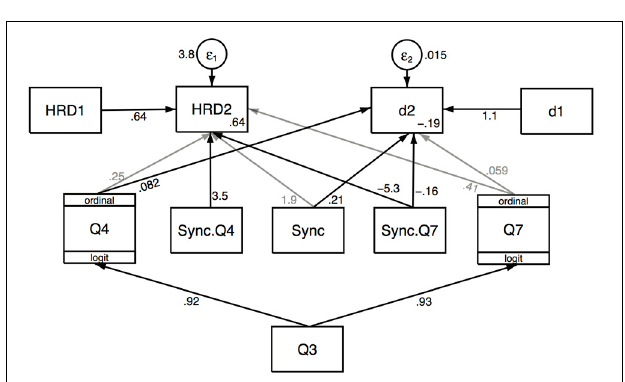
FIGURE 4 | Path analysis for HRD and distance measures in relation to the synchronous/asynchronous condition, and questionnaire variables Q3, Q4 and Q7. The values on the paths are the path coefficients. Table 5 gives full